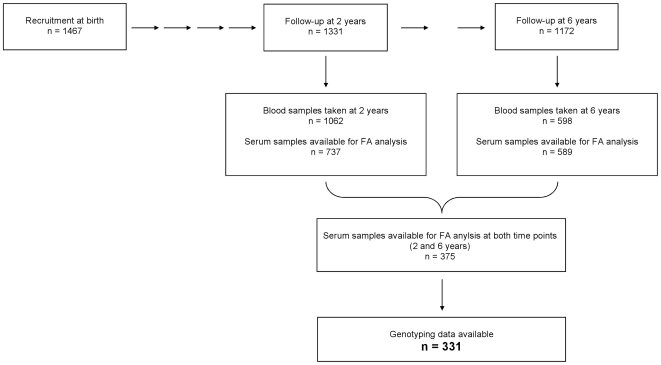
Analyzed serum samples and genetic measurements from the Munich LISA cohort.